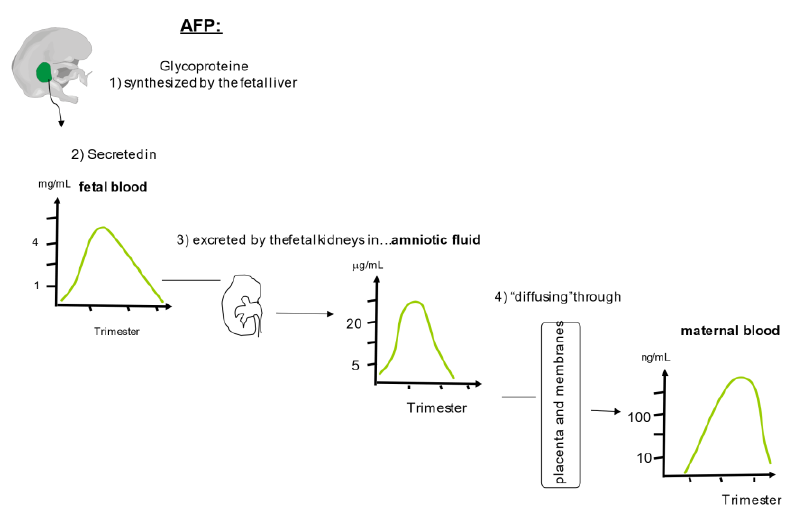
Figure 4. Synthesis and secretion of alpha feto protein (AFP) during pregnancy. AFP is mainly synthetized by the fetal liver and secreted in fetal blood. It is then excreted by the immature fetal kidneys via urine in amniotic fluid, peaking at around 14 WG. Thereafter, renal AFP filtration decreases with kidney maturation and therefore its amniotic levels fall until the end of pregnancy. AFP reaches the maternal circulation through the membranes and placenta. This transfer, which may involve lectins, is very low and reaches a plateau at about 32